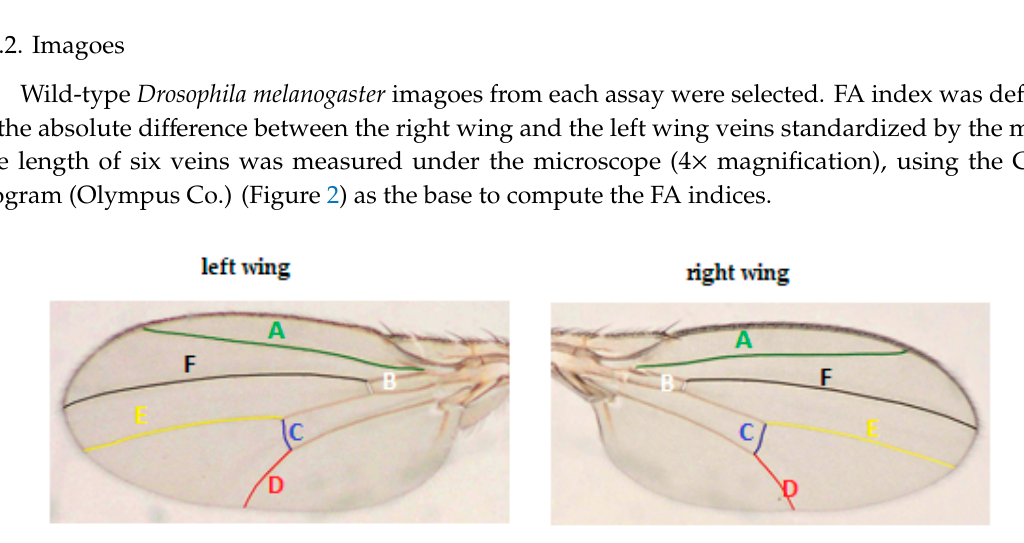
Figure 2. The six measured veins (symbols from A to F) of Drosophila melanogaster .